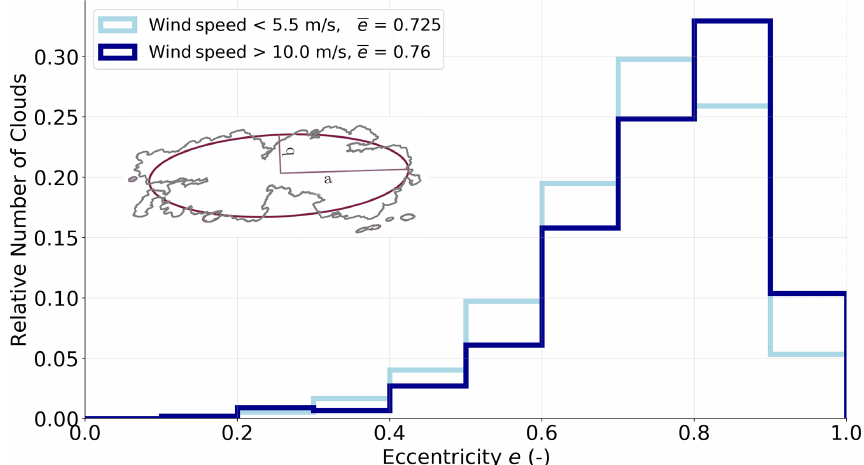
Figure 11. Eccentricity distribution of shallow clouds from RF03 and RF06, showing the relative frequency of clouds in eccentricity bins, with a width of 0.1. The samples are distinguished between low (below 5.5ms − 1 ) and high wind speeds (above 10ms − 1 ) and an exemplary elliptic fit showing major (minor) semi-axis a ( b ) of the